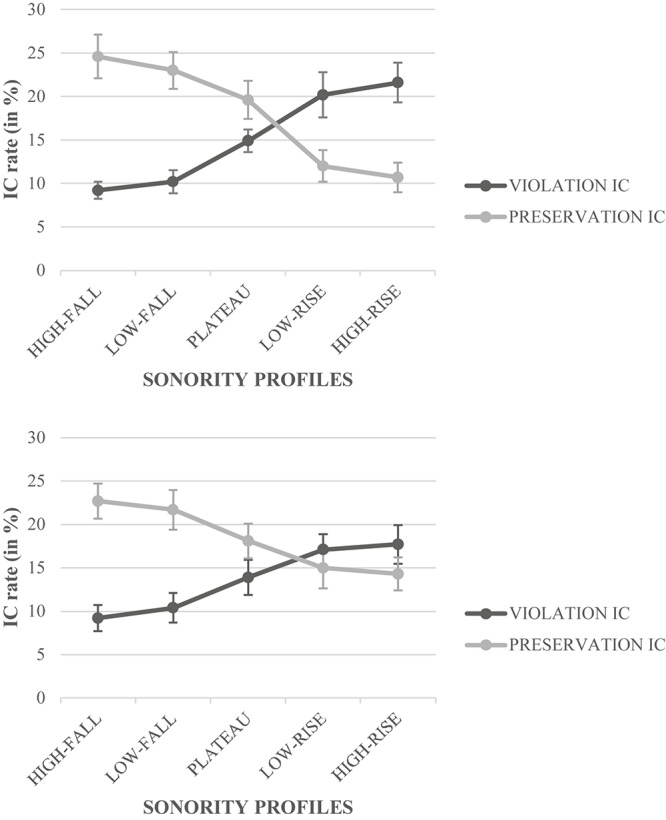
Illusory conjunction rate (IC) in percentage (%) for the Condition × Sonority × Target-letter interaction as a function of the Target-letter (upper panel, the second letter; lower panel, the third letter).